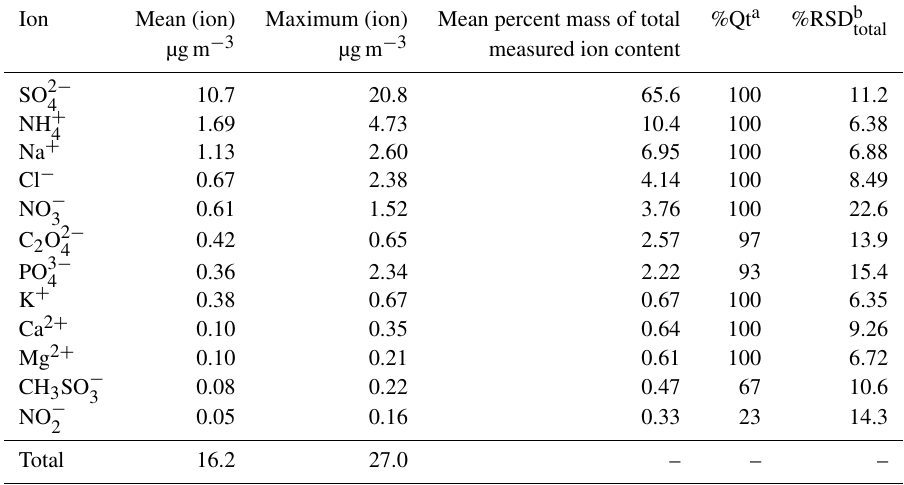
Table 1. Mean and maximum ion concentrations measured throughout the measurement period. The average percent mass contribution of each ion to the total measured ions is included as well as the percent of samples in which each target ion is found (%Qt). Ion Mean